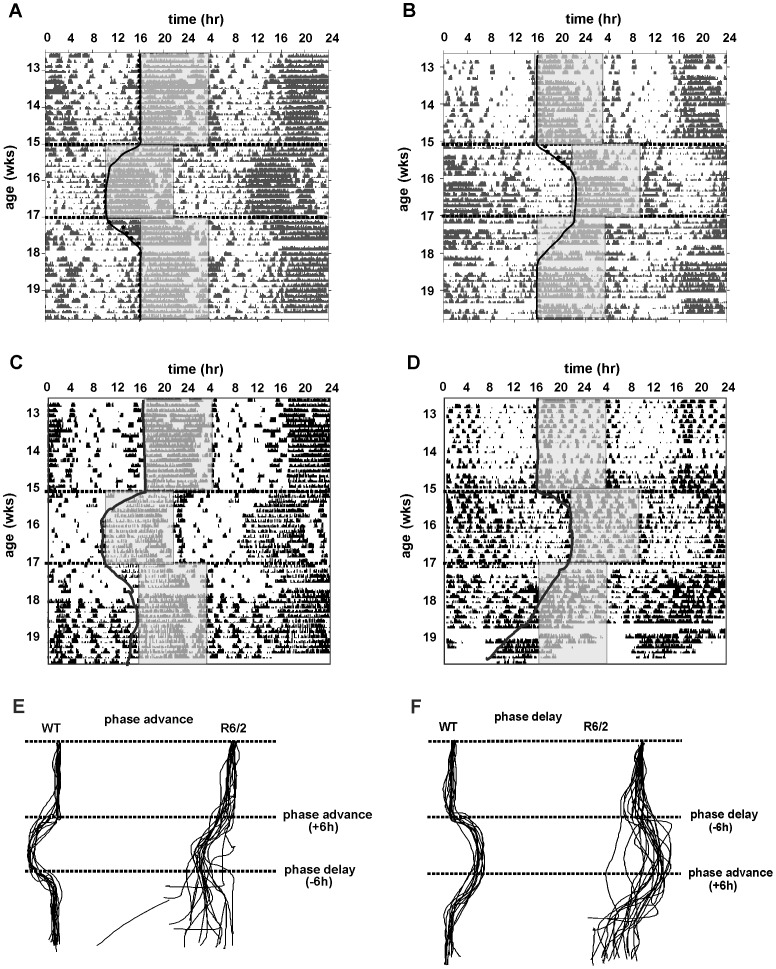
Representative double plotted actograms from mice undergoing phase-advance and phase-delay.WT (A, B) and R6/2 (C, D) mice were exposed to either phase-advance (A and C) or phase-delay (B and D). Shaded regions represent dark phase of LD cycle. Lines were drawn to plot onsets of activity for each mouse (as shown for representative mice in A-D). Lines from all mice are shown superimposed in E and F.